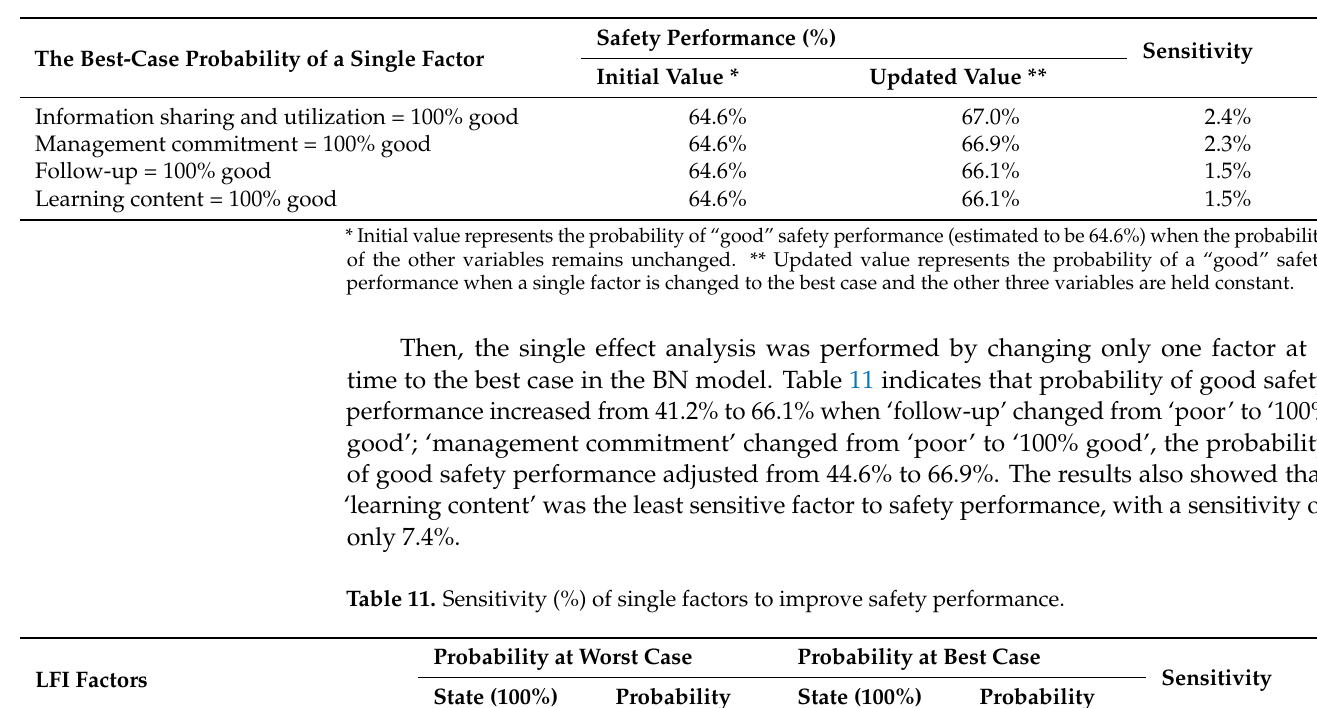
Table 10. Sensitivity of a single factor to improve safety performance.